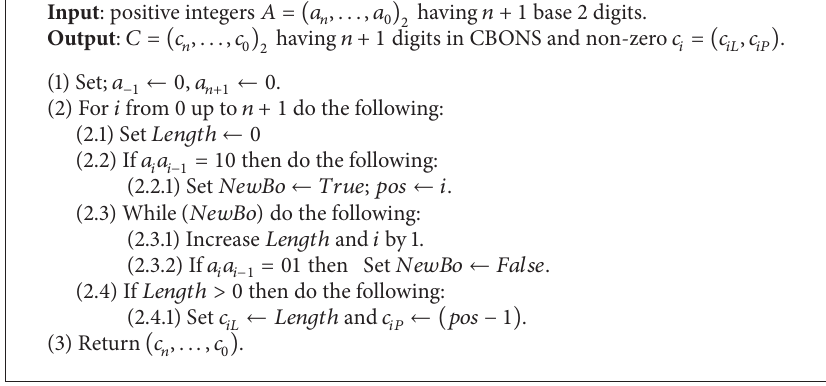
Algorithm 6: Binary to Big-one converter algorithm, 𝐵𝑖𝑛2𝐵𝑂(𝐴) .